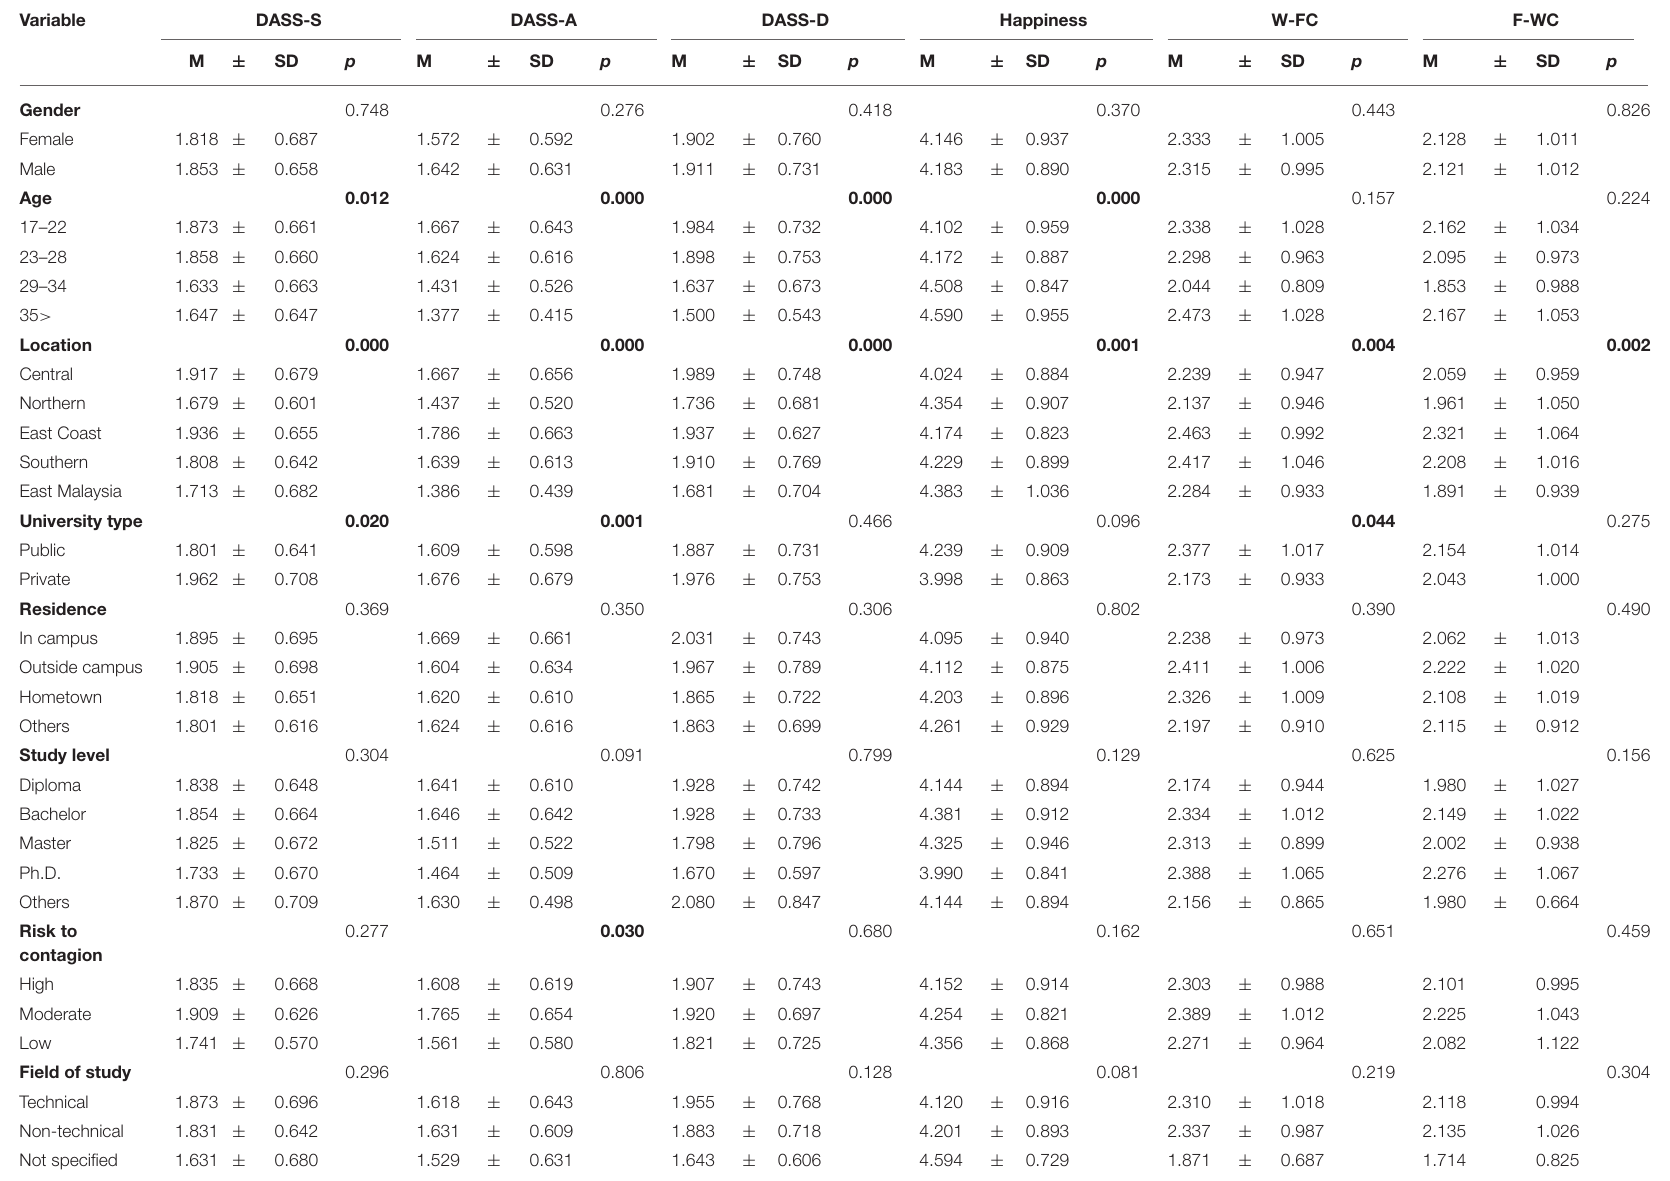
TABLE 5 | Demographic characteristics by the DASS-S, DASS-A, DASS-D, OHQ, and